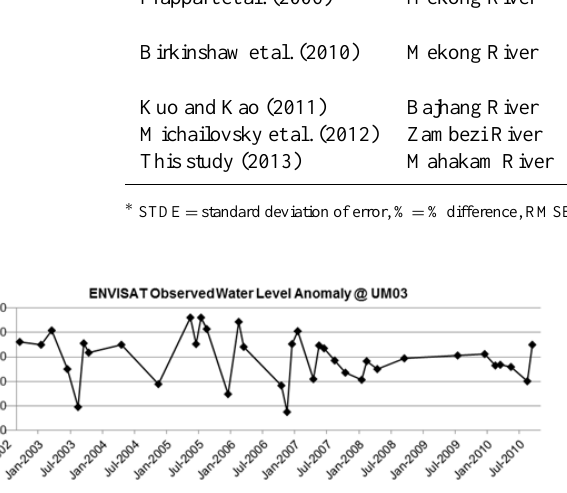
Figure 8. ENVISAT observed water level anomaly at site UM03 (river width 54m) as measured by Envisat RA-2 and processed by the Ice-1 retracker.